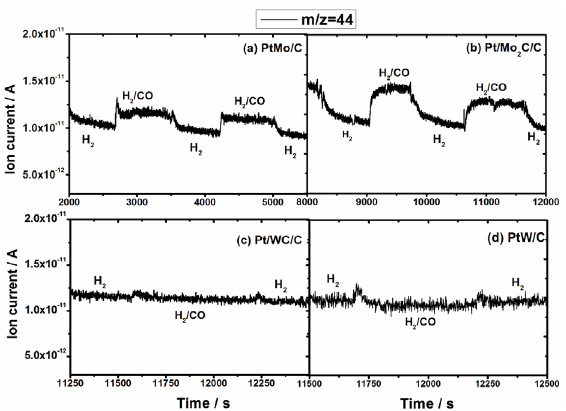
Figure 8 - Current density vs. anode overpotential (η E ) curves recorded for the single cells at 85 o C with various C-C, Pt/ H2/CO 2 freshly prepared anode electrocatalysts, PtMo/C heat-treated at 600 o C, as prepared PtMo/C, Pt/WC/C, and PtW/C. Inset: similar plots for Pt/C and PtFe/C fitted to the OLMS results.